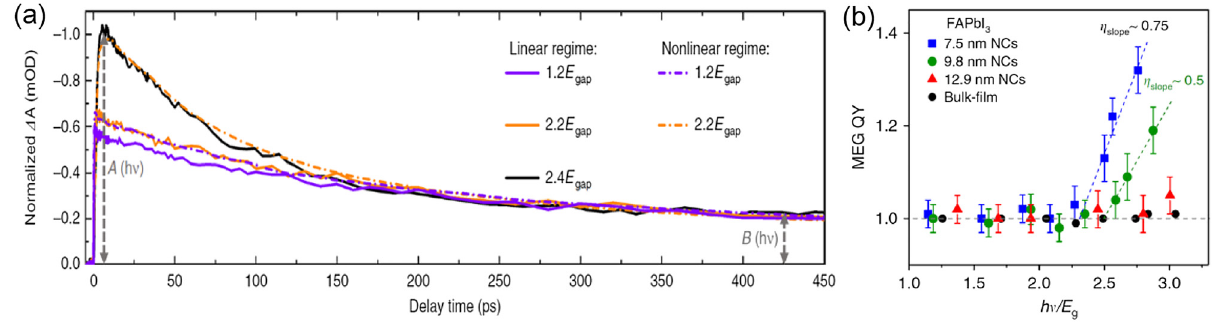
Figure 11: (a) Linear vs. nonlinear regime of TA, showing the decay through Auger recombination with pumping outside the linear regime (by multiphoton absorption) and through carrier multiplication, yield the same dynamics. Reproduced with permission [142]. Copyright 2018, Nature Publishing Group. (b) Quantum yield of multiexciton generation in FAPbI 3 nanocrystals with different sizes are plotted as a function of relative pump photon energies ( h ν / E g ). Reproduced with permission [143]. Copyright 2018, Nature Publishing